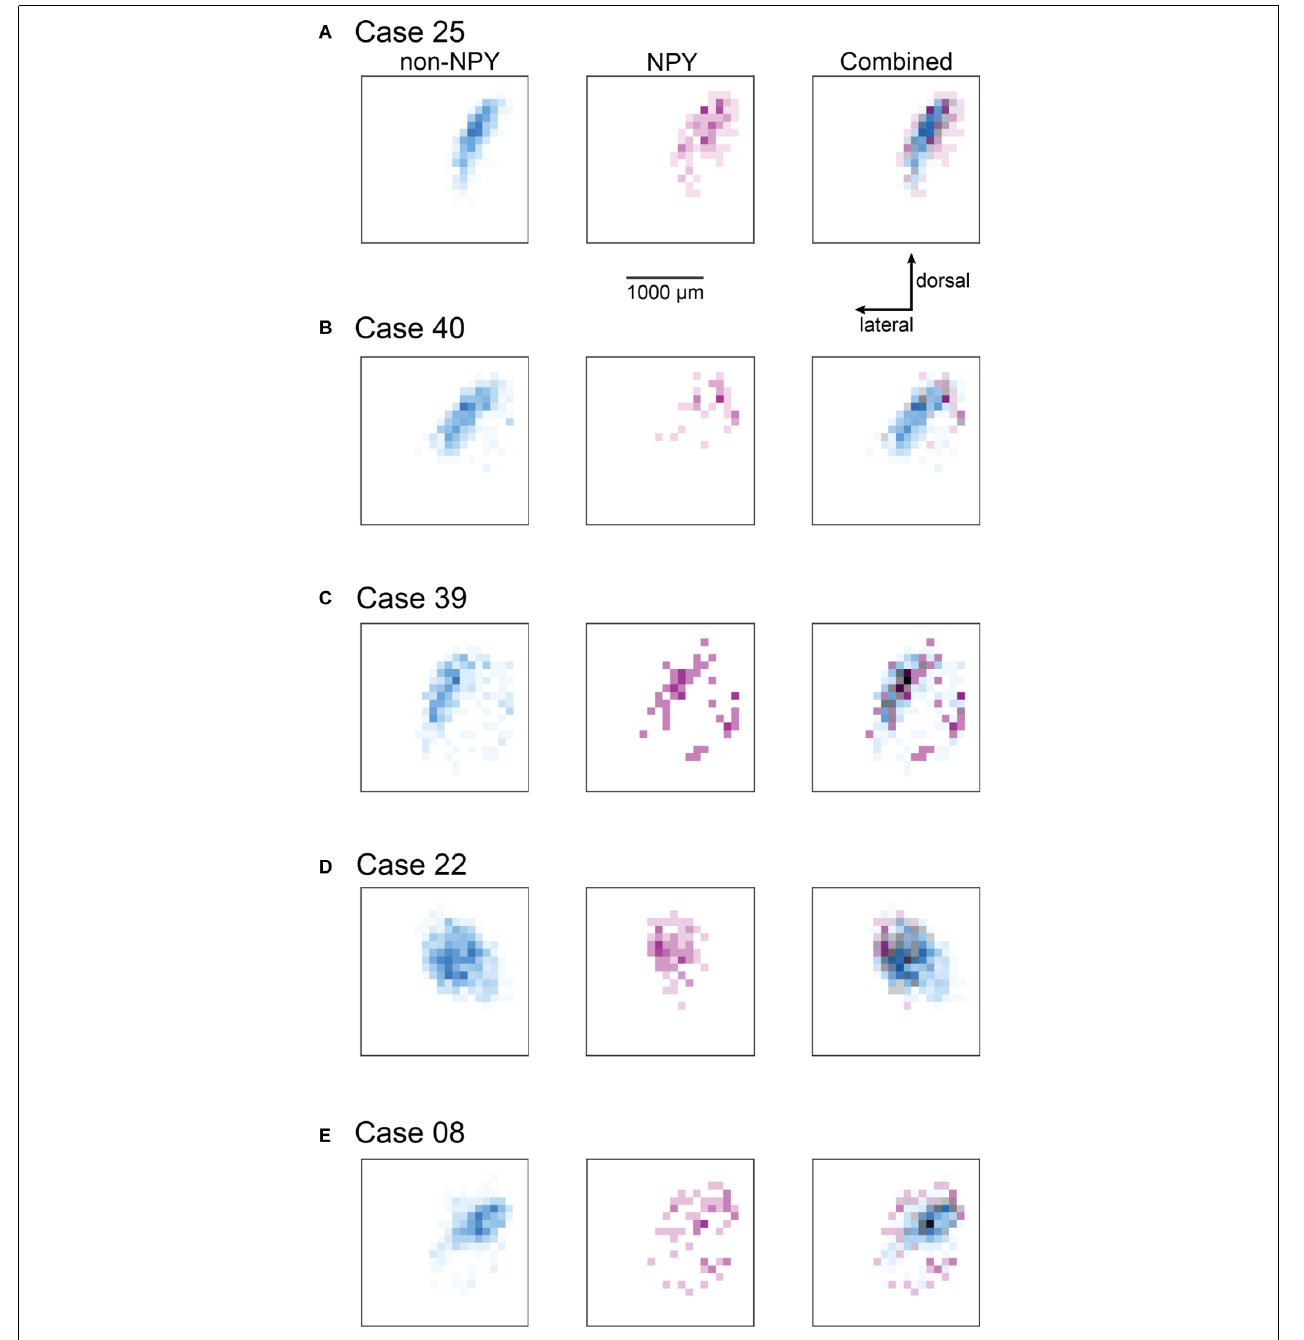
FIGURE 4 | Heatmaps highlight the more heterotopic distribution of RB-labeled NPY neurons in the ICc compared to RB-labeled non-NPY neurons. For each of the ICc injection cases, reconstructions of coronal sections of the left IC were aligned and flattened in the rostral-caudal dimension ( Z -axis), and the density of RB-labeled neurons in the ICc was calculated in the coronal plane using 100 µ m 2 bins. RB-labeled neurons in the ICd and IClc were excluded from this analysis. (A–E) The density of RB-labeled non-NPY neurons in the left ICc is shown in cyan (left), while the density of RB-labeled NPY neurons in the left ICc is shown in magenta (middle). More intense colors indicate higher neuron densities normalized separately to the maximum density of non-NPY neurons (left) and NPY neurons (middle). Merged overlays of the non-NPY and NPY densities (right) reveal that NPY neurons were more common at sites surrounding the main mass of the non-NPY density. Bins where non-NPY and NPY neurons strongly overlapped appear in gray, with darker grays indicating more overlap. Case numbers are indicated in the subpanel labels. The scale bar and dorsal and lateral direction arrows in (A) also apply to (B–E) . In (A–C) the main pattern of non-NPY neuron labeling follows a ventrolateral to dorsomedial orientation, consistent with the labeling of one or more isofrequency laminae, and the distribution of NPY neurons in these cases generally shows higher densities at regions bordering the main band of non-NPY labeling. In (D,E) the distribution of RB-labeled non-NPY neurons is broader, with a less laminar shape than observed in (A–C) , but RB-labeled NPY neurons remain more common at sites bordering the main pattern of non-NPY labeling.